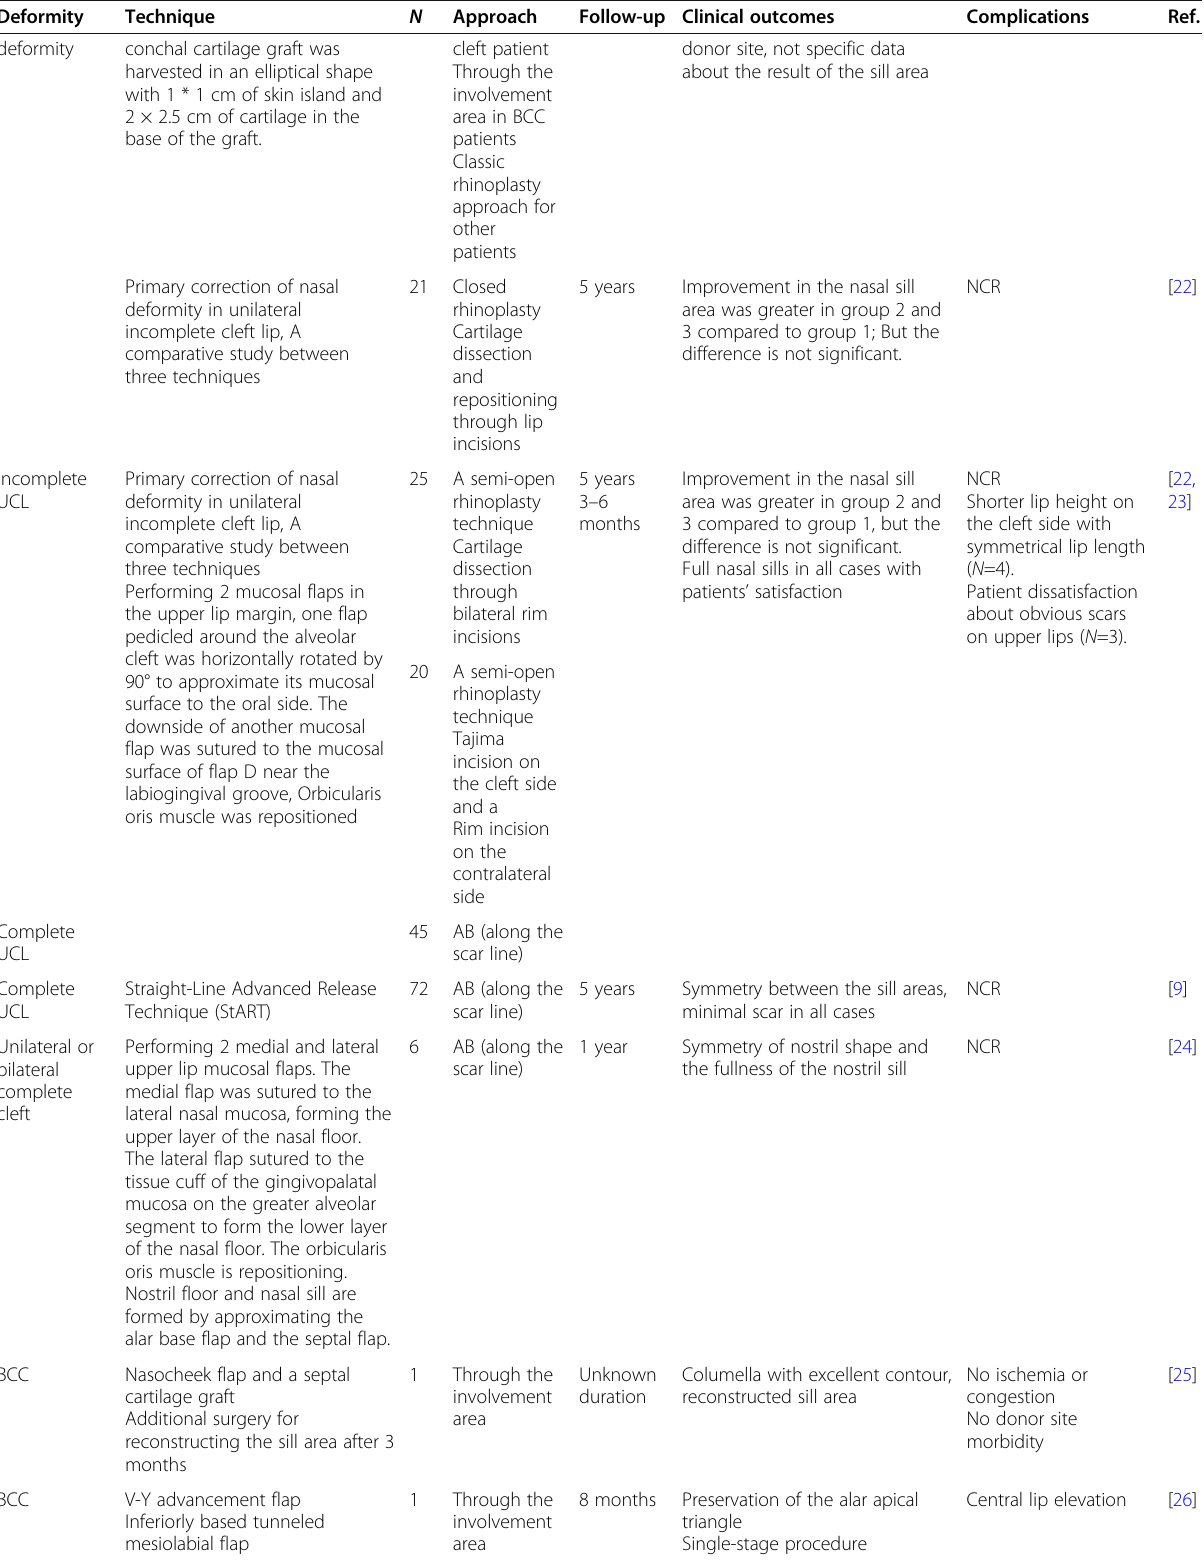
Table 2 The data of articles addressing the sill graft/augmentation in terms of the technique, approaches, clinical results, and complications. UCL , unilateral cleft lip; BCC , basal cell carcinoma; AB , alar base; NCR , no complications reported (Continued) Deformity Technique N Approach Follow-up Clinical outcomes Complications Ref.